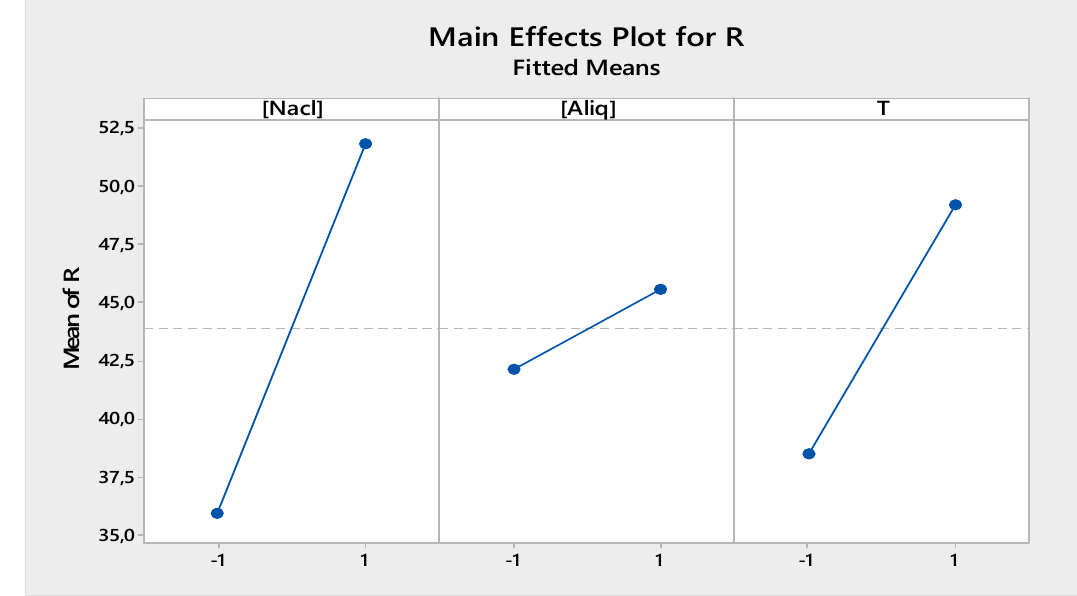
Figure 9. Factors of main effects plot for receiving phase.